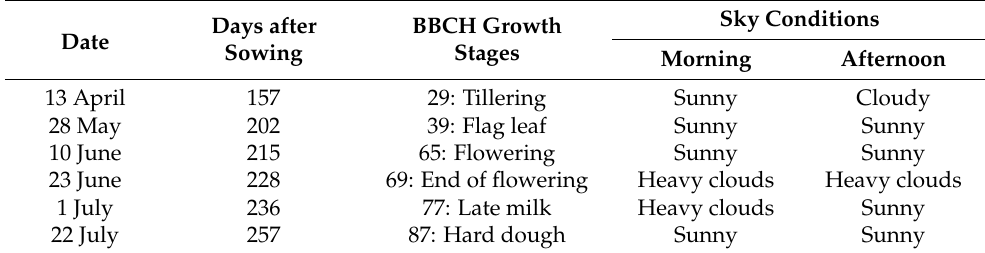
Table 1. Dates of all-day-long